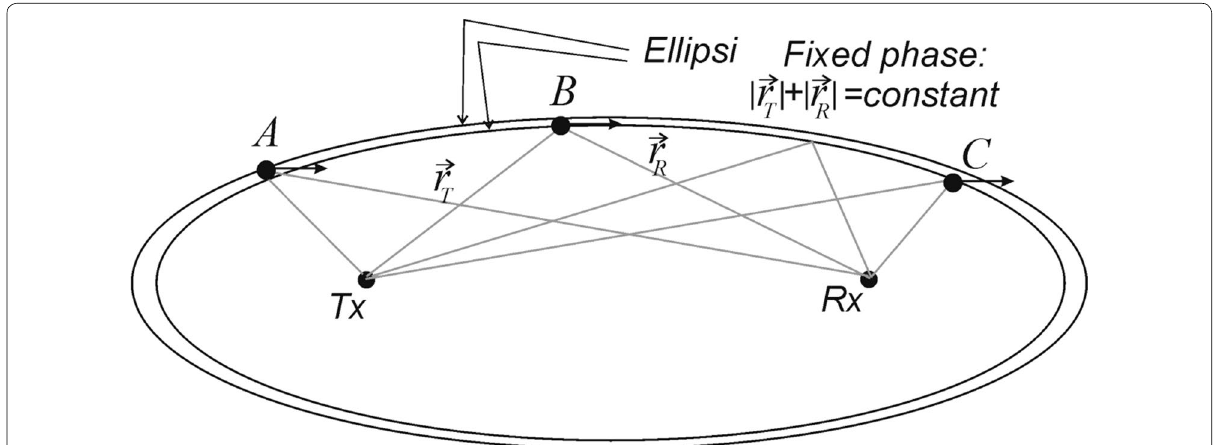
Fig. 1 Sketch showing the nature of scattering in bistatic mode, showing a vertical cut through two surfaces of constant “range”